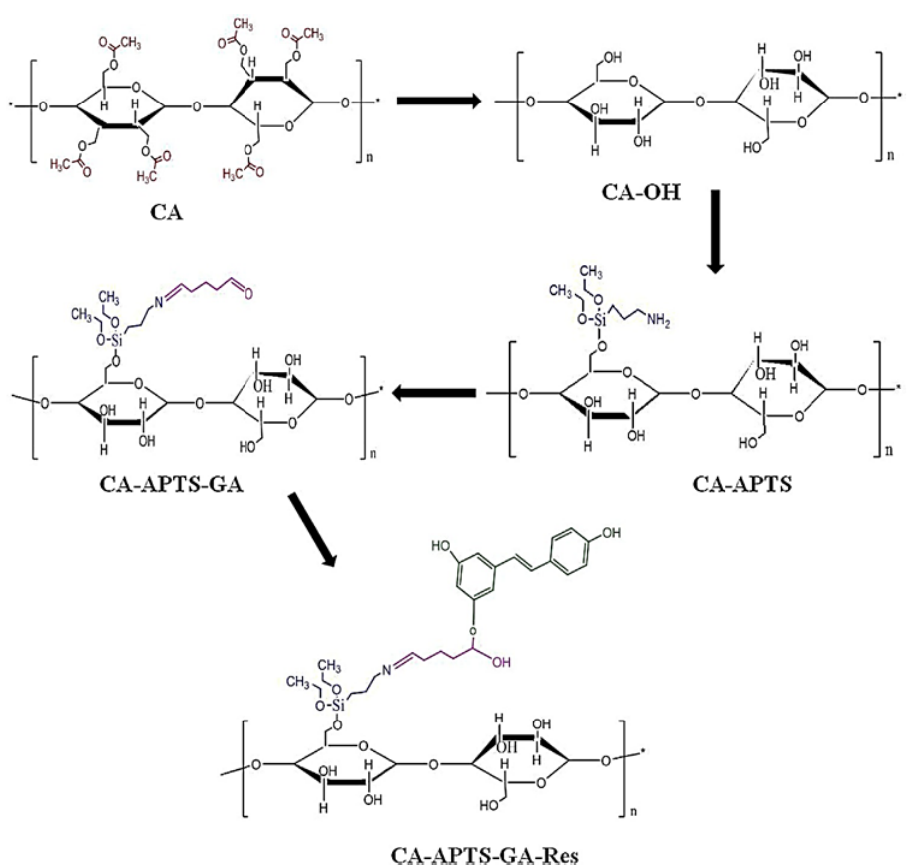
Figure 8. Schematic representation of the reaction sequence for the derivatization of cellulose acetate membranes with resveratrol (reproduced with permission after [238] ).